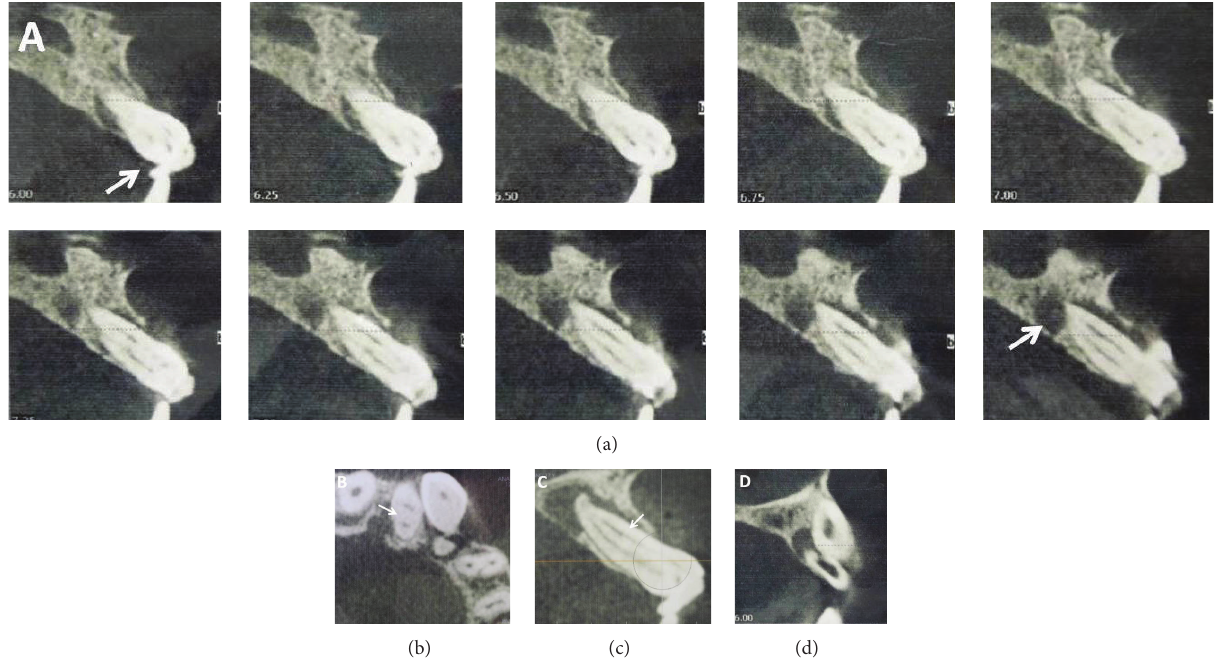
Figure 2: Cross sectional CBCT images showing (a) the presence of a structure which is composed of enamel and dentin in relation to the crown of maxillary left central incisor and also a well-defined periapical radiolucency with respect to its root. (b) Axial image showing two root canals in left maxillary central incisor (c) single root with two distinct root canals, one each on the labial and palatal aspect. (d) Periapical radiolucency and perforation defect in relation to left lateral incisor.